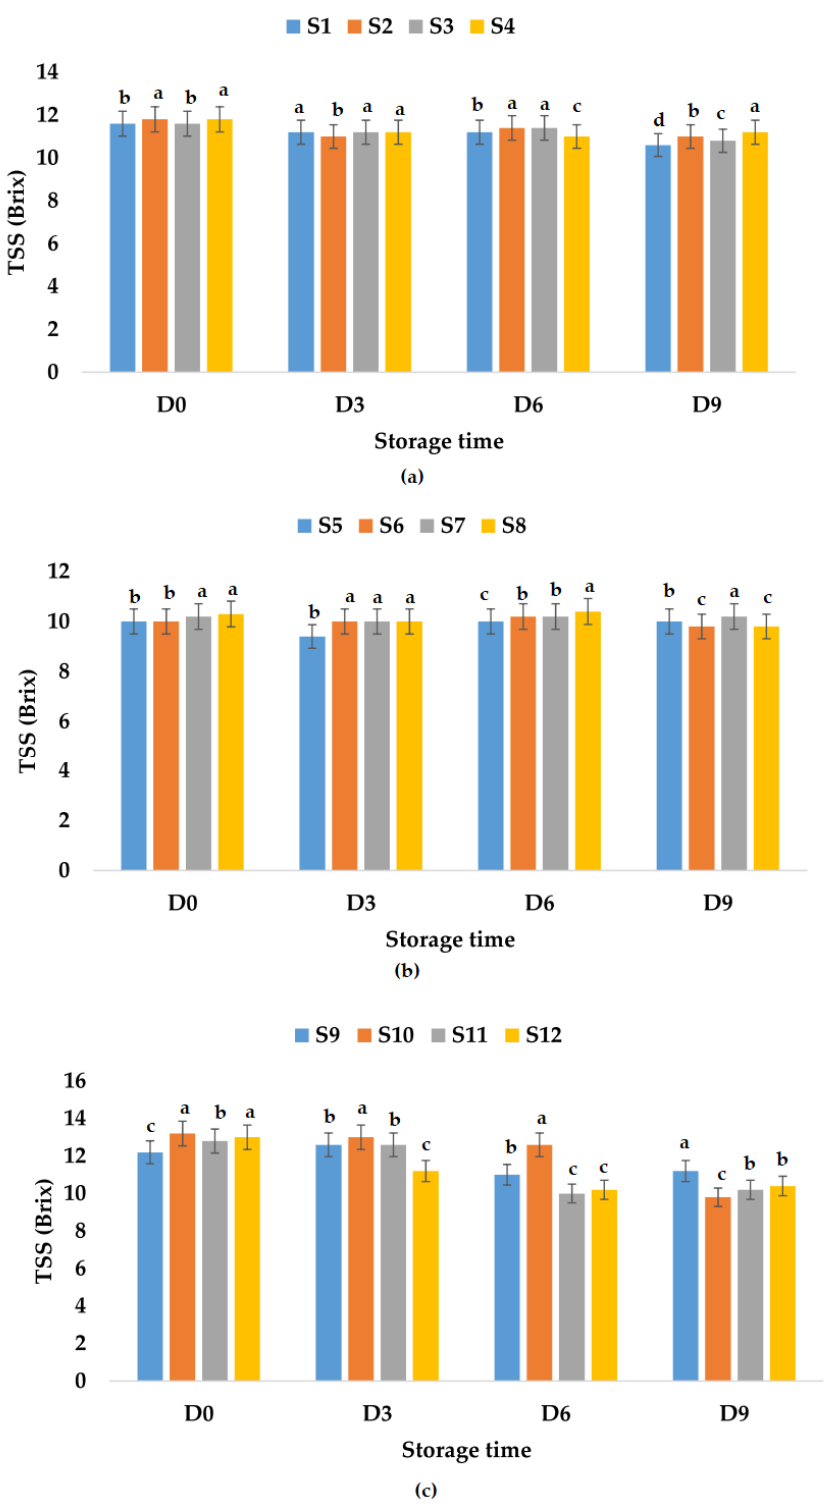
Figure 7. Variation in TSS ( ◦ Brix) of juice samples during the storage period (D-day) at refrigeration temperature (4 ◦ C): ( a ) apple juice samples (S1, S2, S3, S4); ( b ) apple and pumpkin juice samples (S5, S6, S7, S8); ( c ) apple and pomegranate juice samples (S9, S10, S11, S12). Means with